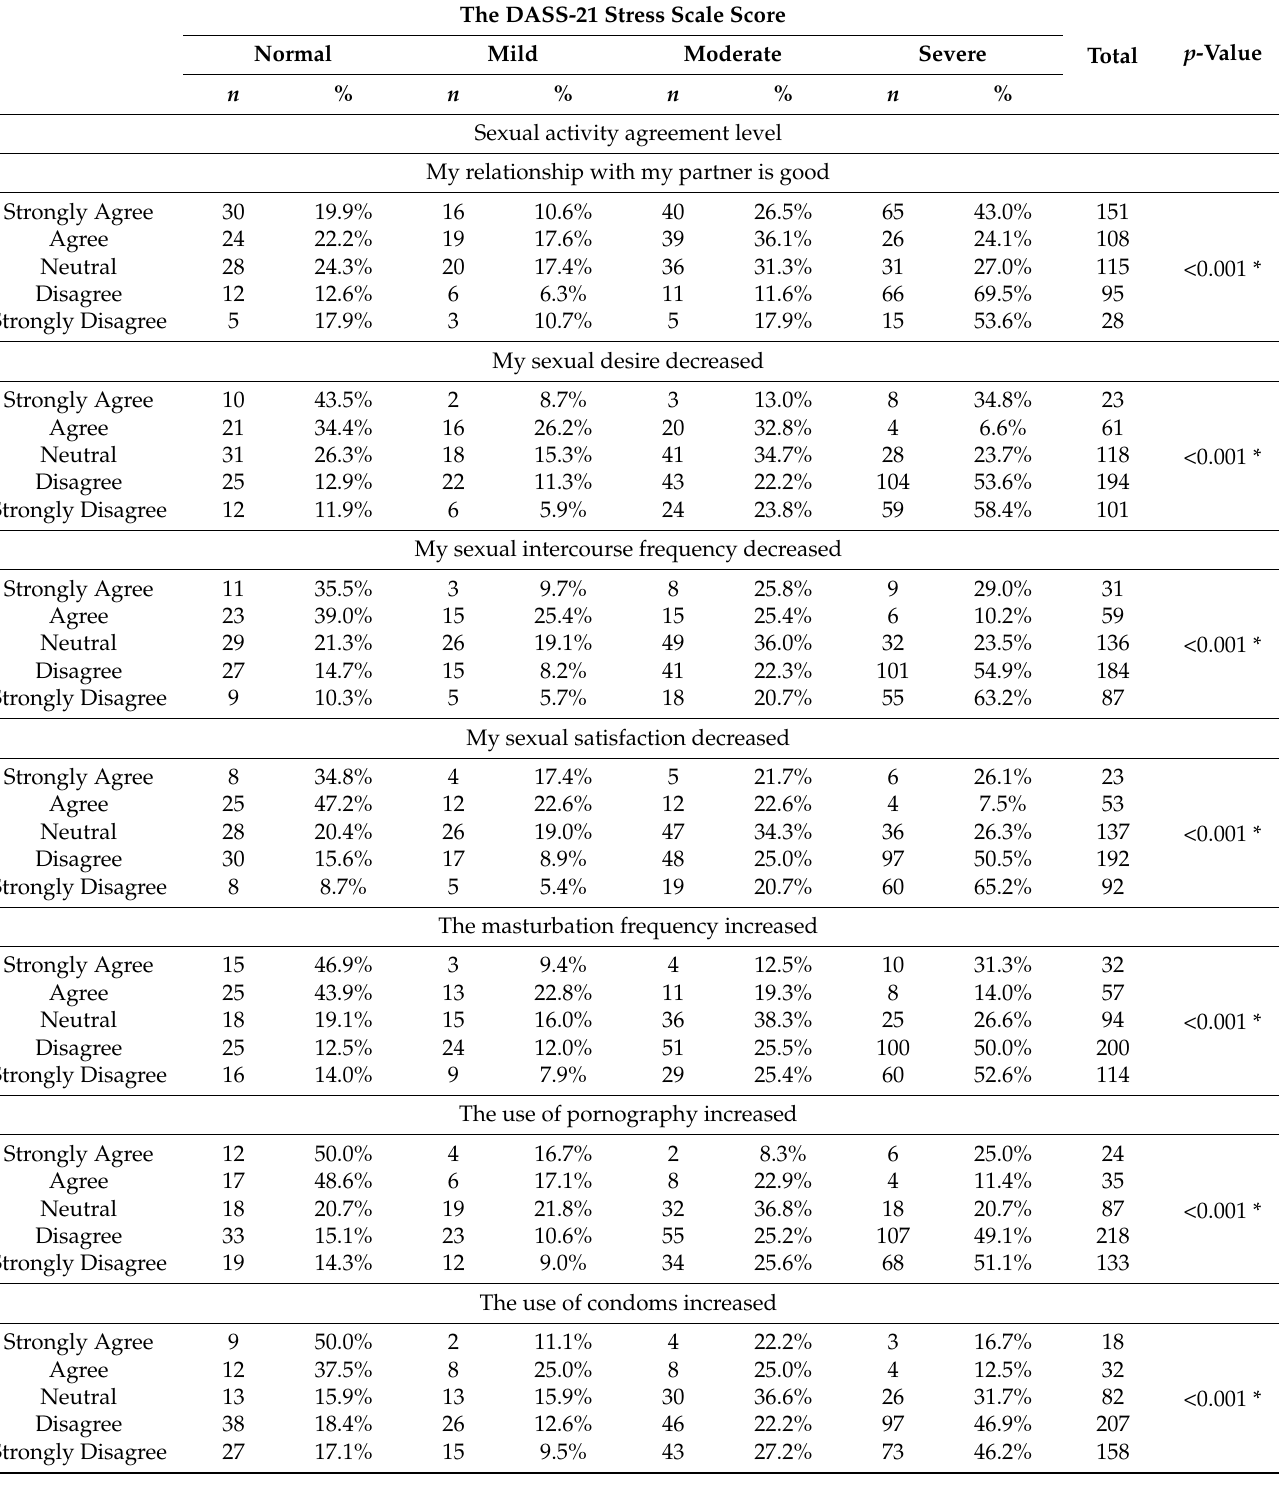
Table 6. Correlation between the DASS-21 stress scale score with sexual activity of COVID-19 responders during pandemic